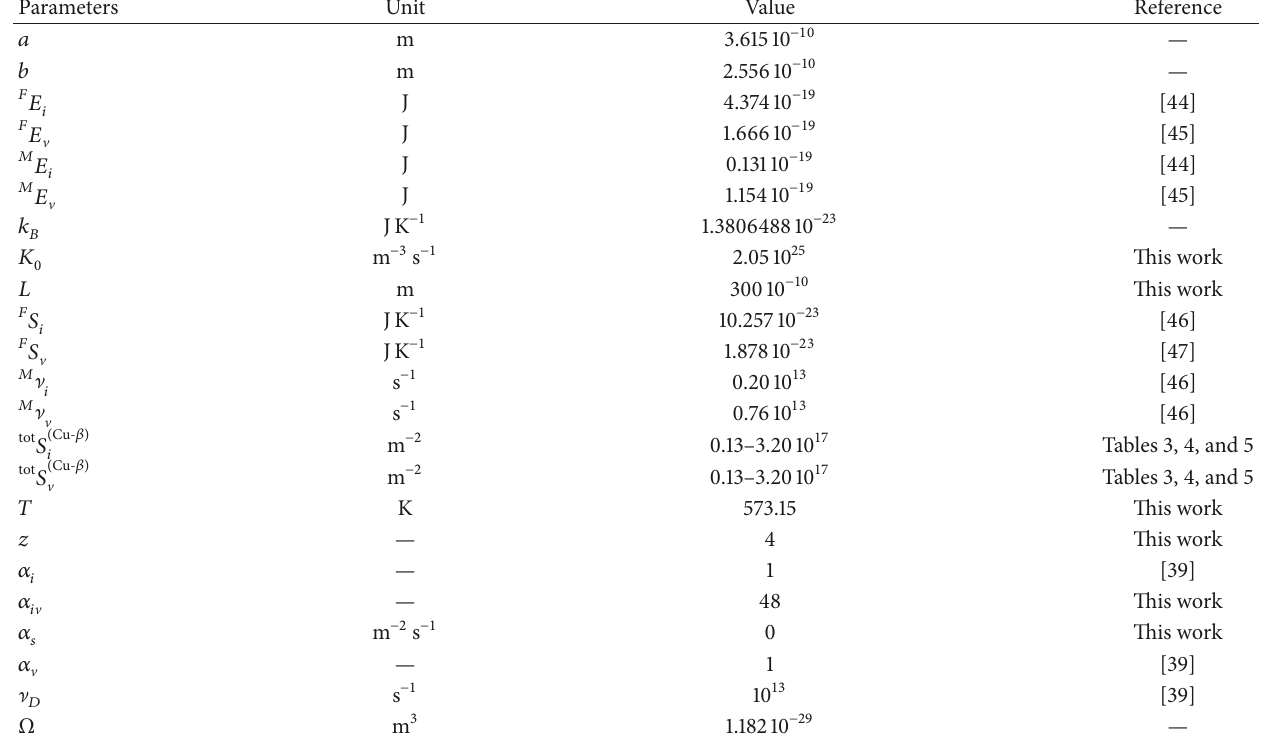
Table 2: Model parameters for copper.